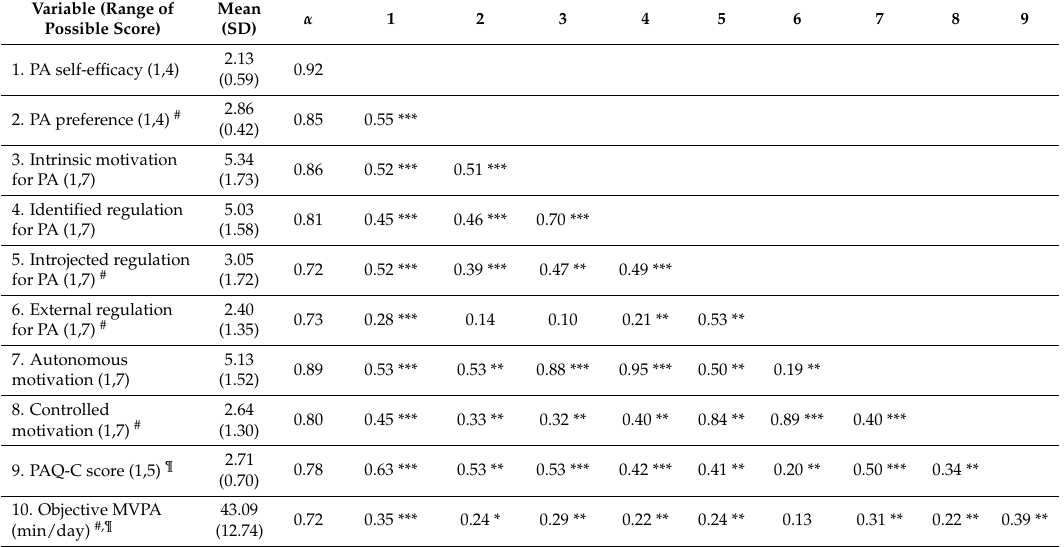
Table 2. Descriptive statistics, internal reliability coefficients and Pearson correlation coefficients ( n = 449). Variable (Range of Possible